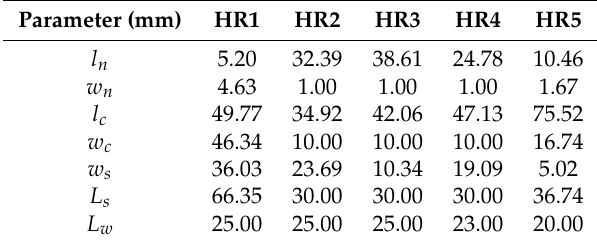
Table 1. Optimized geometrical parameters obtained for each Helmholtz resonator composing the system to maximize the absorption coefficient in f = [ 400,560 ] Hz.